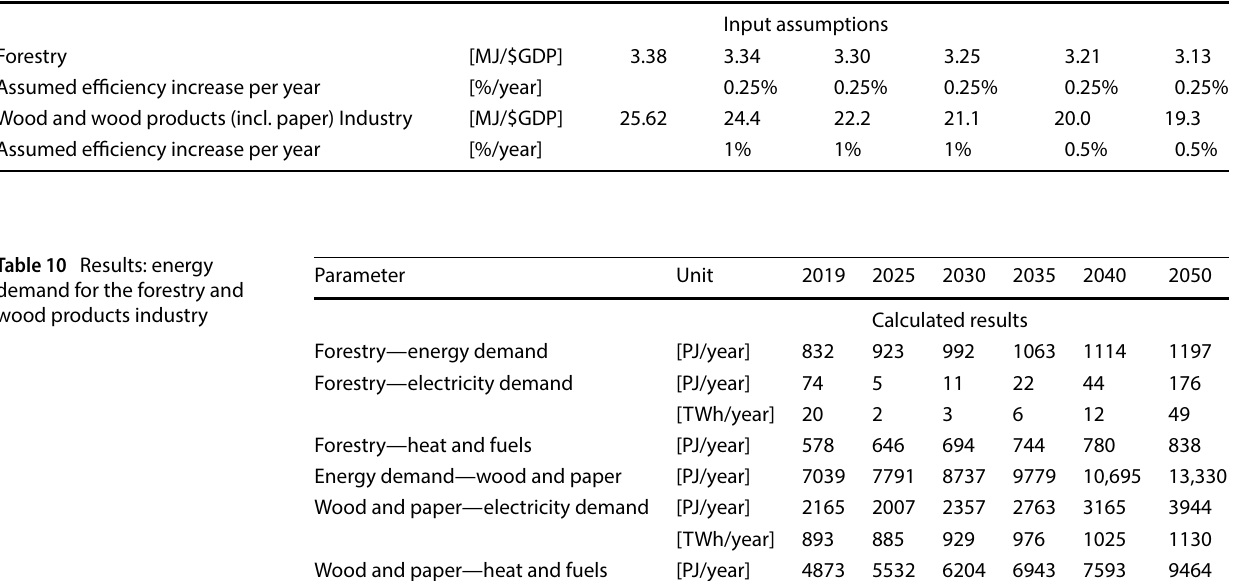
Table 9 Assumed energy intensities for the forestry, wood, and wood products industry Energy intensities